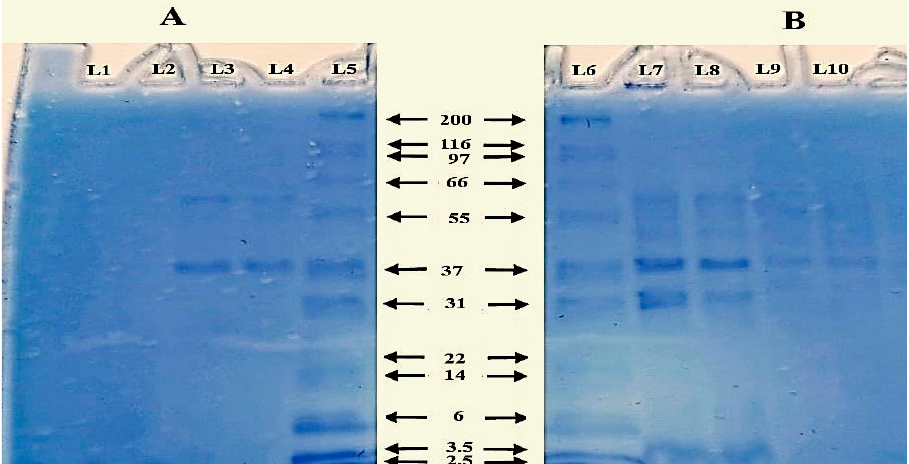
Figure 2. SDS-PAGE analysis of the protein content of treated and untreated NmC cells. A photo of 12% SDS-PAGE showing ( A ) the protein content of the supernatants of untreated bacterial culture (Lanes 1–2) and BG cell culture (Lanes 3–4) against a protein marker (Lane 5). ( B ) The protein content of untreated bacterial cell pellets (Lanes 7–8) and BG pellets (Lanes 9–10) against a protein marker (Lane 6).